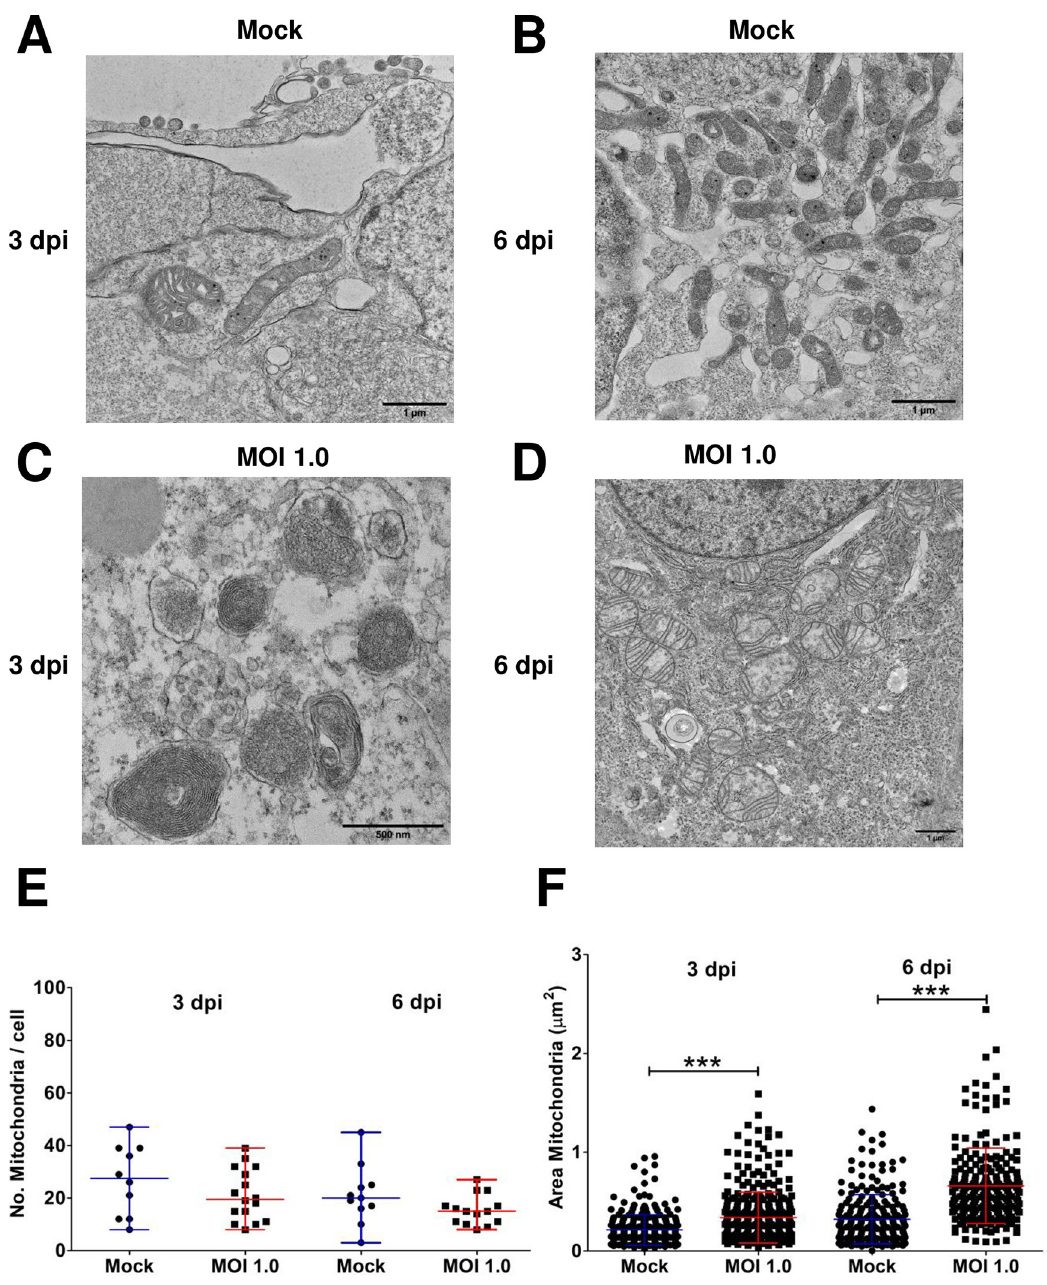
Fig 7. ZIKV infection in astrocytes-hNS1 causes changes in the mitochondria. The astrocyte-hNS1 culture was infected with ZIKV (MOI of 1) or mock-infected. The monolayers were fixed at 3 and 6 dpi and processed for observation by transmission electron microscopy. (A) Mock-infected cells at three dpi. (B) Mock-infected cells at six dpi. The mitochondria of the mock- infected cells show the homogeneous size and parallel cristae. (C) ZIKV-infected cells during 3 dpi showing mitochondria with concentric cristae and mitochondria with the sparse mitochondrial matrix. (D) ZIKV-infected cells 6 dpi showed decreased mitochondrial cristae and lighter electron density. (E) Quantitative analysis of the number of mitochondria per cell, the mean and standard deviation are presented, p = 0.06, ANOVA. (F) Quantitative analysis of the size of the mitochondria expressed in the mitochondrial area ( μ m 2 ), the median and range are presented, p < 0.0001, Kruskal Wallis test with a post hoc Dunn’s Multiple Comparison Test. In order to compare the area of the mitochondria we only analyzed organelles with the same orientation.